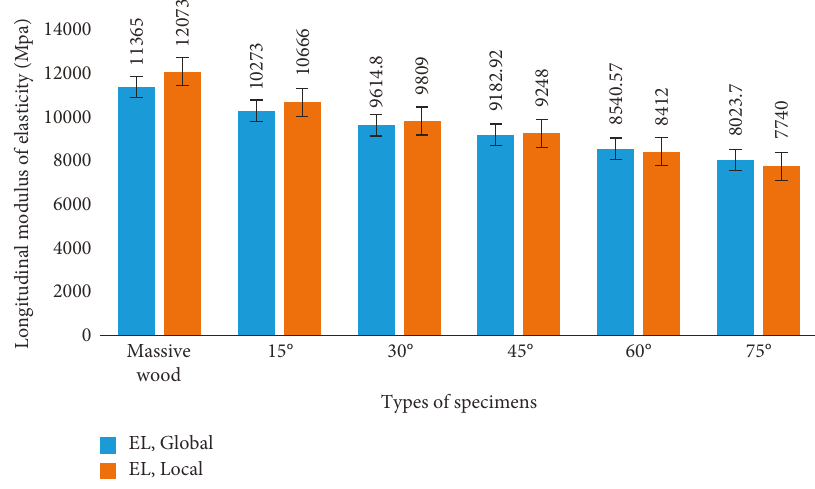
Figure 10: Comparison of longitudinal modulus of elasticity of solid and finger-jointed timber. Table 2: Bending mechanical properties resulting from various assembly configurations in comparison with other species. Specimen